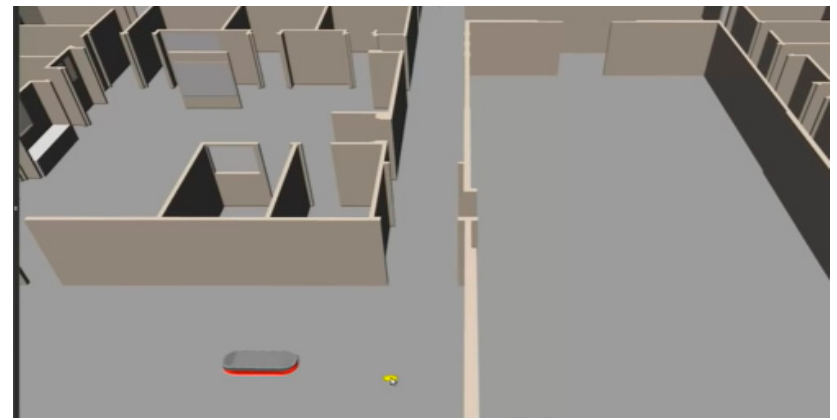
Figure 22. Gazebo visualization of an AGV moving on a path.